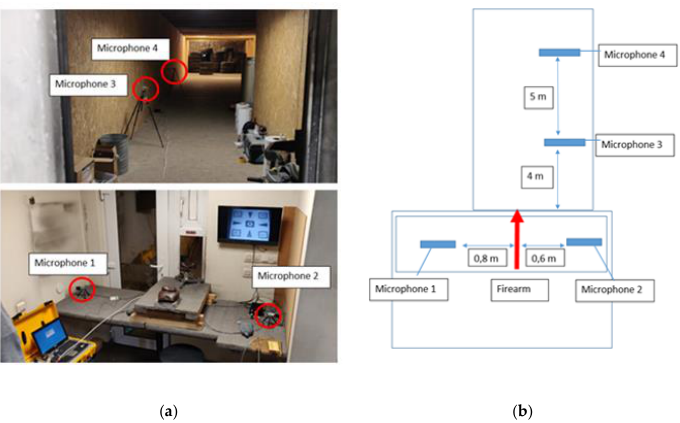
Figure 2. Experimental site ( a ) consisting of the range of the shooter, the range of the bullet and a layout of the microphones ( b ). In this study, short and high-frequency acoustic pulses of more than 140 dB prevail during the shot, so high-quality vibration measuring instruments from the Danish com- pany Brüel & Kjæ r are used. Vibration and other dynamic measurement and analysis equipment is used to test the acoustic characteristics, including Brüel & Kjæ r Mobile Di- agnostics Toolbox Type 7927, with a Dell Computer and Grass 46DP Microphones. Meas- uring points 1 and 2 (microphones 1 and 2 in Figure 2a) are located at a distance of 0.8 and 0.6 m from the shooter on the left and right sides, respectively. The position of measuring points 3 and 4 (microphones 3 and 4 in Figure 2a) are at a distance of 4 and 9 m from the